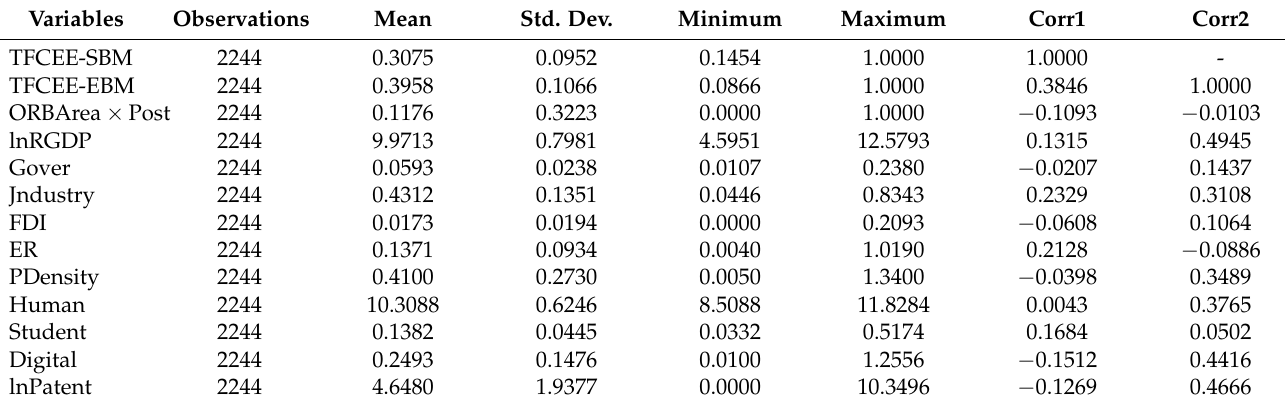
Table 2. Descriptive